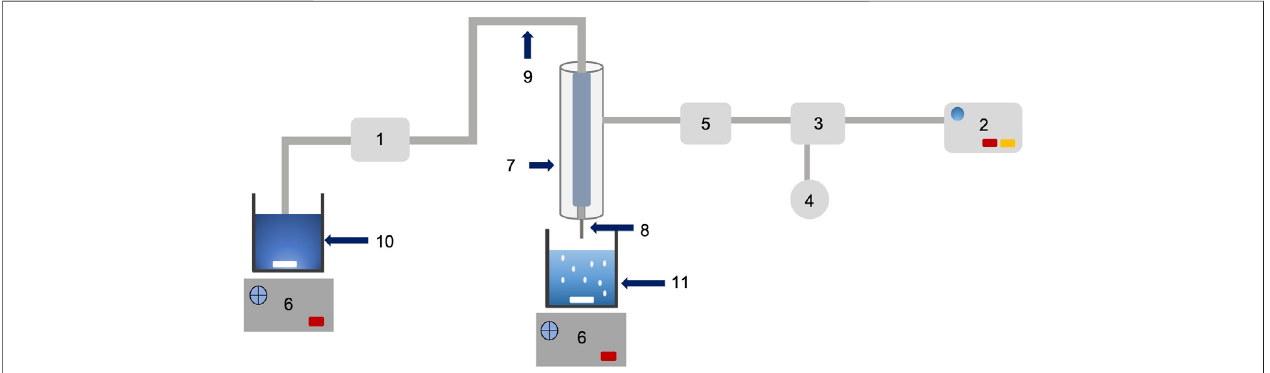
FIGURE 1 | Schematic diagram and working of bead making unit (designed and fabricated of low cost encapsulation machine): peristaltic pump (1); air pump (2); pressureregulator(3);pressuregauge(4);air fi ltermembrane(5);magnetic stirrer control(6);doublestainless steeljacket (7);needle(8);rubbertube (9);mixture solution (10); and gelling beaker